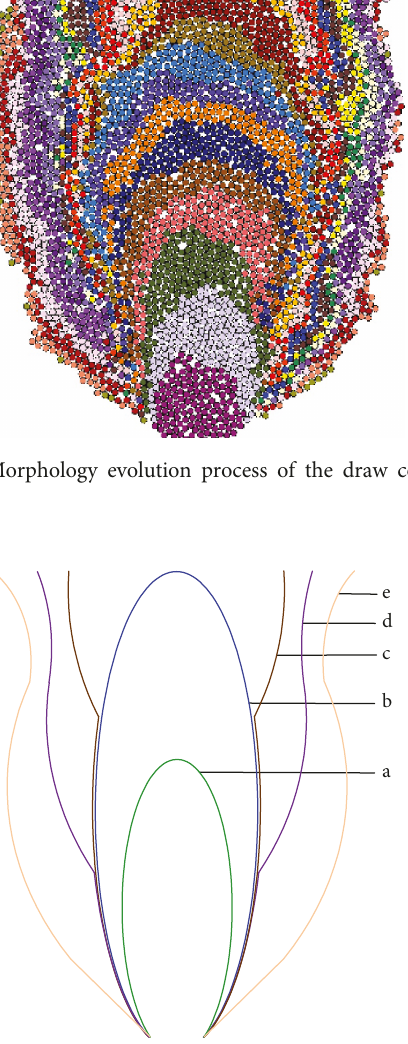
Figure 6: Diagrammatic plan of the morphology evolution process of the draw column in the test: (a) transitional ellipsoid, (b) limit ellipsoid, (c and d) transitional gyrostat, and (e) limit gyrostat. Table 5: The test data in the boundary of the draw column.